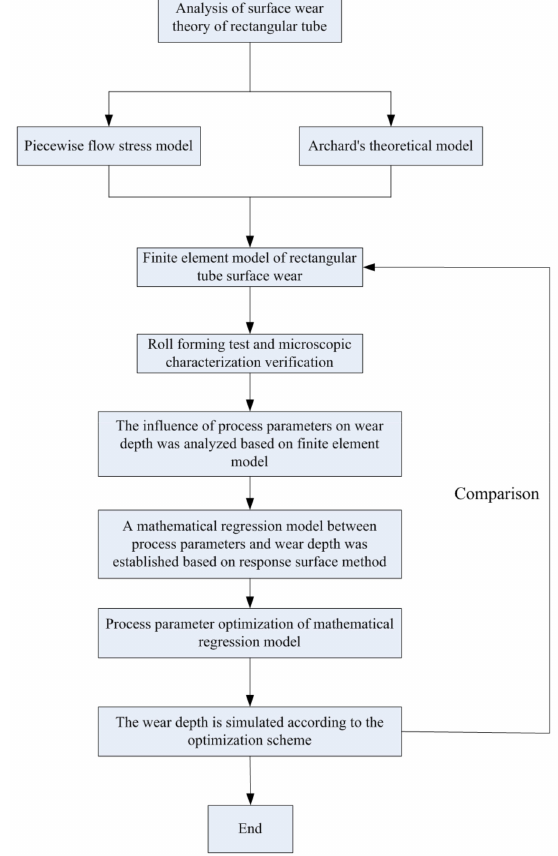
Figure 18. Flow chart of the wear